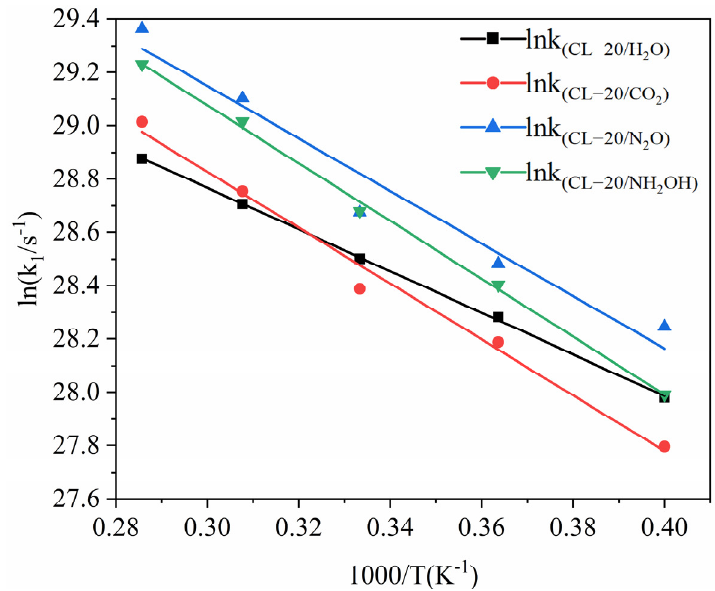
Figure 5. The logarithm of reaction rate (ln( k 1 /s − 1 )) against inverse temperature (1/T) in the exother- mic decomposition stage at different temperatures. Thick trendline corresponds to the actual concen- tration data of corresponding matching color.